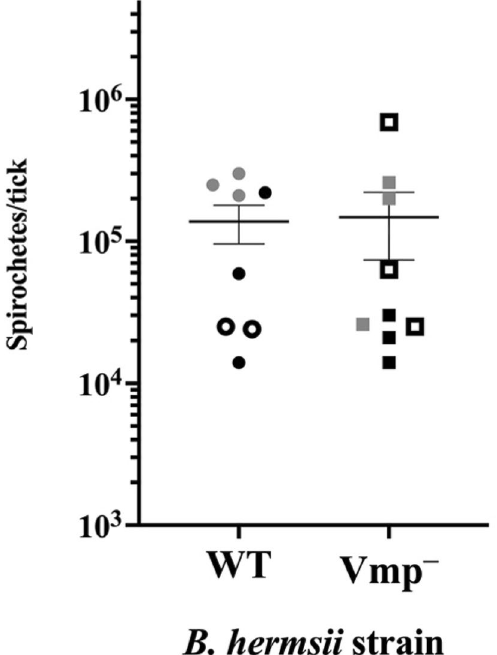
Figure 3. Numbers of B. hermsii spirochetes in O. hermsi ticks post-feeding. Immediately after feeding through artificial membranes on infected blood, individual ticks were crushed and spirochete densities determined by colony count on solid medium. No significant difference was observed between acquisition of the WT strain and the Vmp – mutant as calculated by an unpaired, 2-tailed T-test. Each symbol represents B. hermsii densities within an individual tick, and differences in shading indicates independent feeding experiments (3 total). Bars represent the mean ± the standard error of the mean.